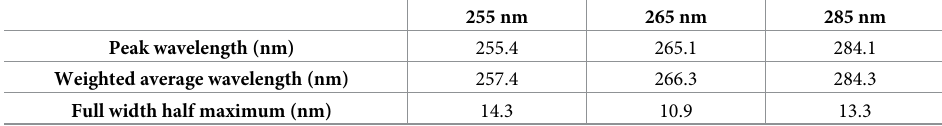
Table 1. Technical specifications of UV LEDs.